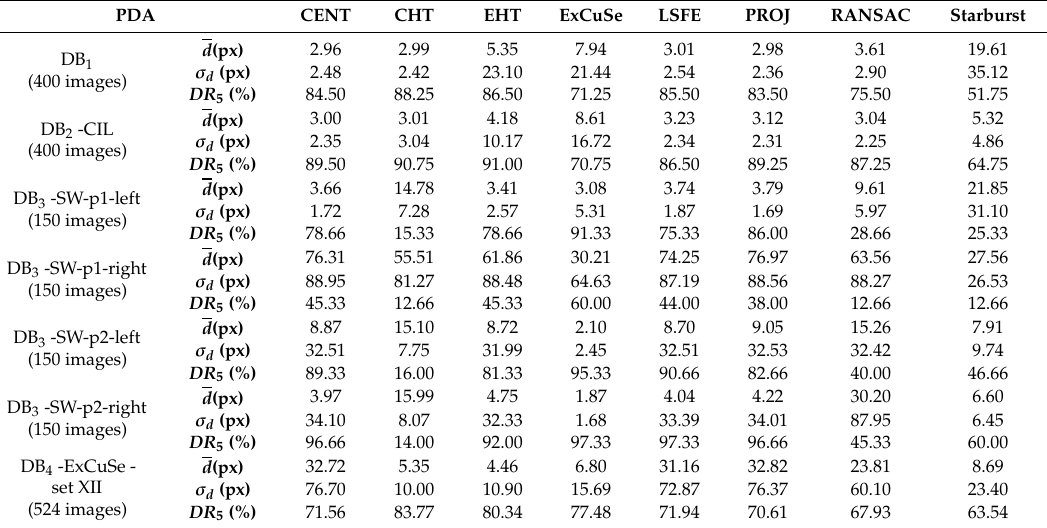
Figure 8. Detection rate vs. pixel error for all PDAs running on databases ( a ) DB 1 , ( b ) DB 2 -CIL, ( c ) DB 3 -SW-p1-left, ( d ) DB 3 -SW-p1-right, ( e ) DB 3 -SW-p2-left, ( f ) DB 3 -SW-p2-right, ( g ) DB 4 -ExCuSe. Table 1 illustrates the mean values ( ), standard deviations ( σ d ) of the pixel error, and the detection rate at five pixels ( DR 5 ), obtained by running each analyzed PDA on all four databases of eye images. The detection rate at five pixels represents the percentage of the eye pupil images for which the pixel error is lower than five pixels. Table 1. Performances of the PDAs for static eye images from all four databases.